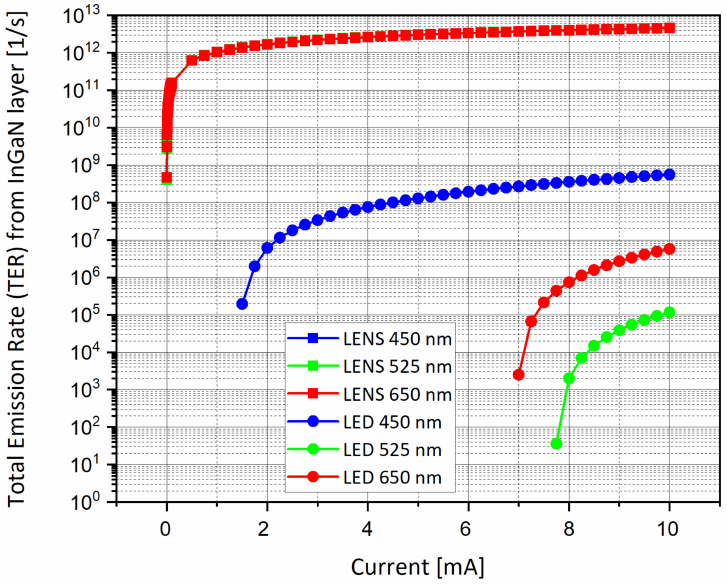
Figure 11. Total emission rate (TER) from the InGaN layer for several wavelengths for cylindrical and conical